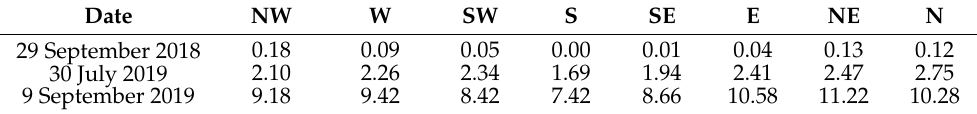
Table 5. Statistical indicators of damaged stand distribution depending on the slope aspect.